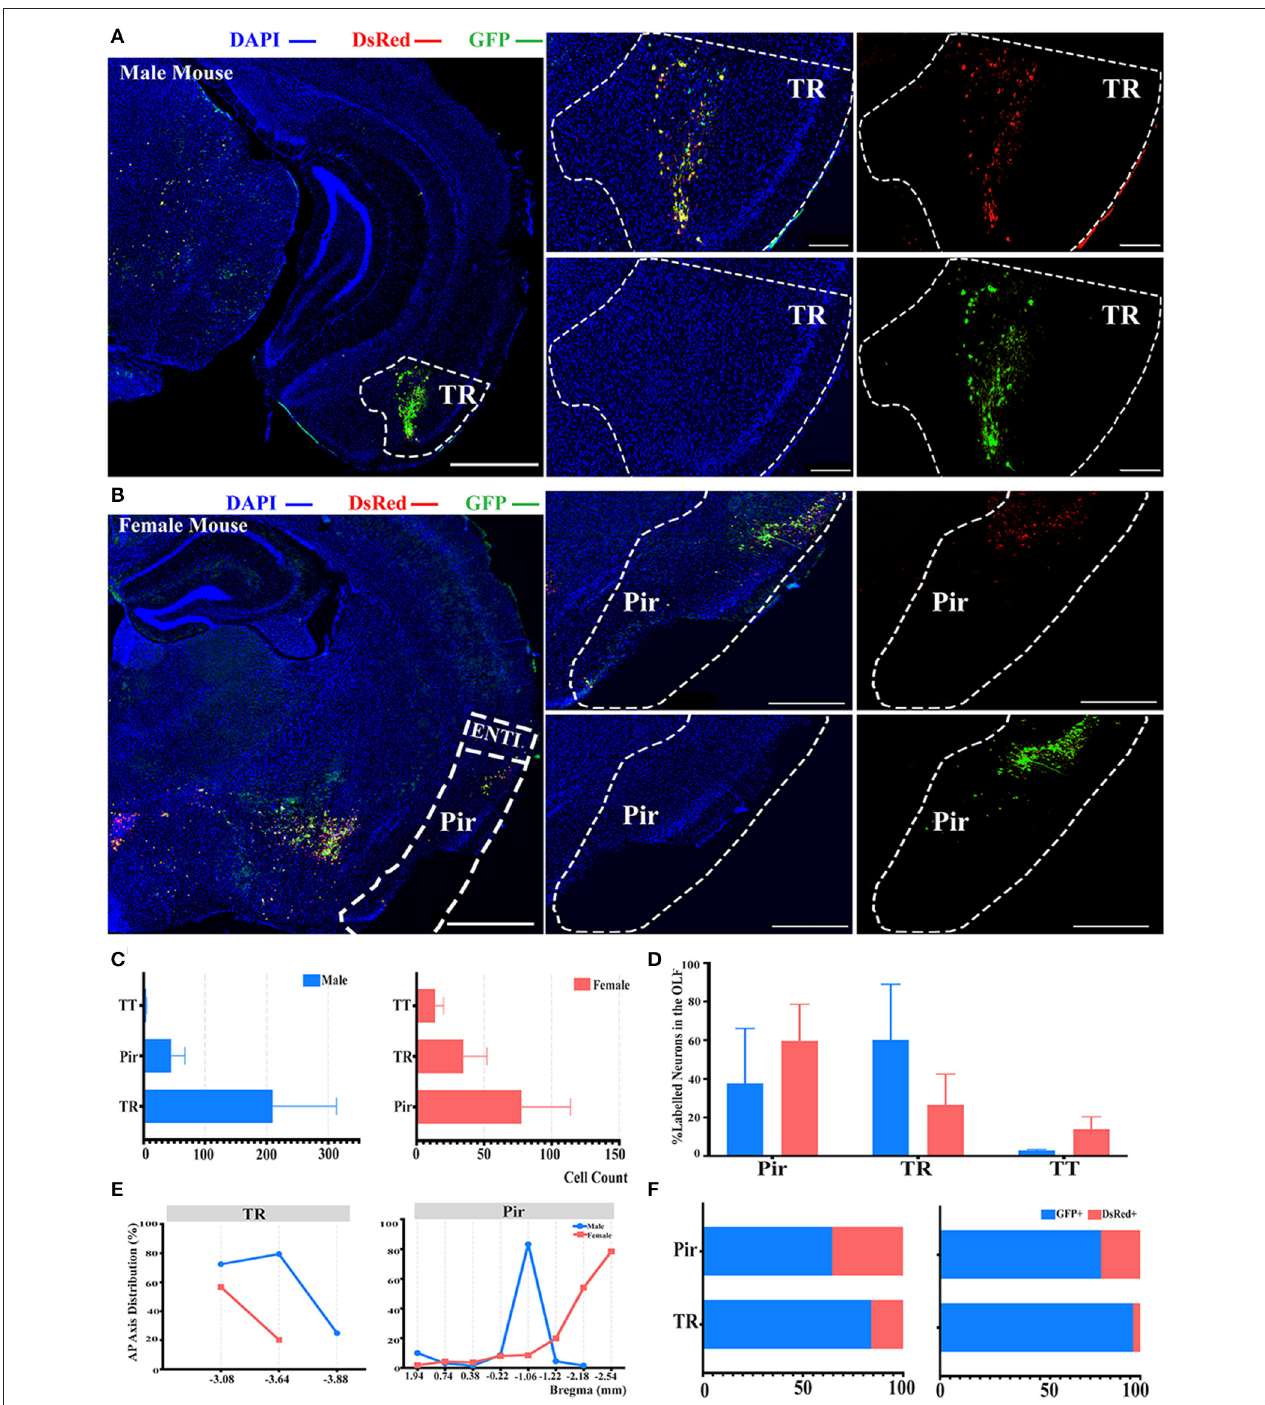
FIGURE 4 | Distribution patterns of labeled neurons in OLF. (A,B) Representative images showing labeled neurons from the mouse ipsilateral OLF to the ELGs. Scale bar: 1mm (left lower magnification images) and 200 µ m (right higher magnification image); ( A , male; B , female). (C) Number of labeled neurons (GFP + and dsRed + ) in different subregions of OLF (left, male; right, female). (D) Distribution of the labeled neurons within OLF (significant difference labeled on the bar top, otherwise n.s.). (E) Distribution patterns of the labeled neurons along the AP axis in different subregions of OLF. (F) Distribution of GFP + and dsRed + within subregions of OLF (left, male; right, female). GFP + , PRV-GFP positive neurons; dsRed + , PRV-dsRed positive neurons. n.s., no significant difference.